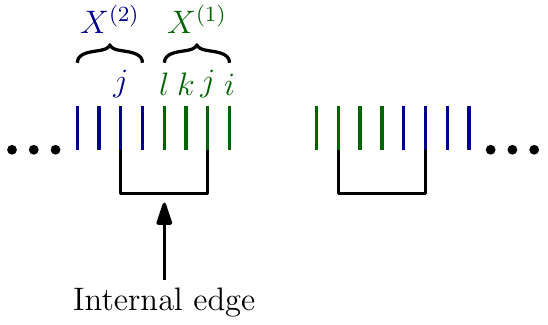
Figure 15 . The diagram corresponding to a single insertion of a marginal density matrix.